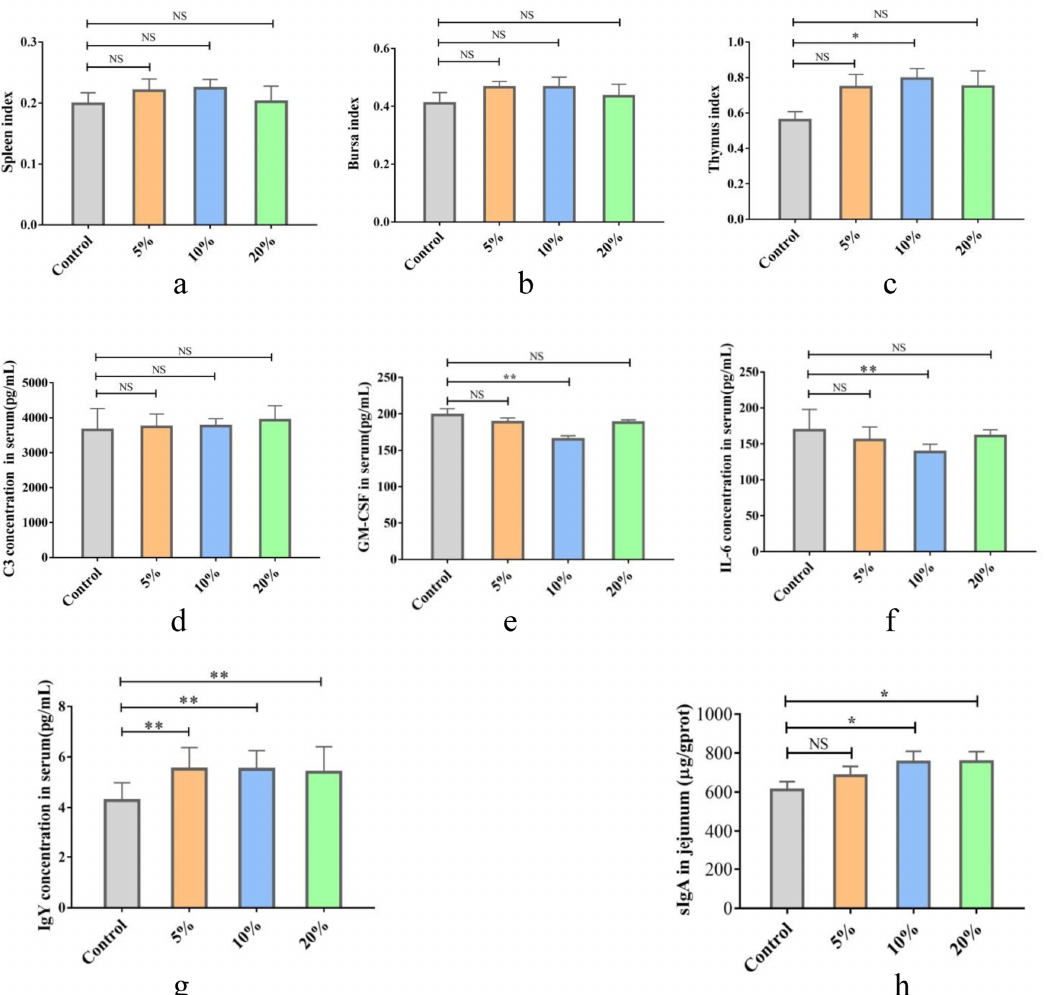
Figure 3. The effect of TWW on the immune indexes of chickens. ( a – c ) The relative weights of the spleen, bursa, and thymus, respectively. ( d ) Complement C3 content in serum. ( e ) Granulocyte-macrophage colony-stimulating factor (GM-CSF) content in serum. ( f ) Interleukin-6 (IL-6) content in serum. ( g ) Ig Y content in serum; ( h ) Secretory IgA (sIgA) content in jejunum tissues. Values presented as means ± SEM. * p < 0.05, ** p < 0.01, compared with the control group. NS: no significance between the indicated groups.